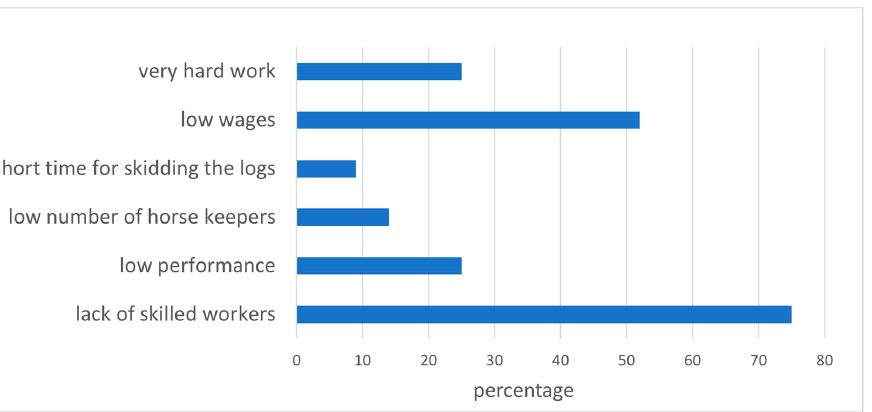
Figure 3. Reasons for not applying horse loggers in those Hungarian hilly forest districts where no horse logging occurs in 2021.